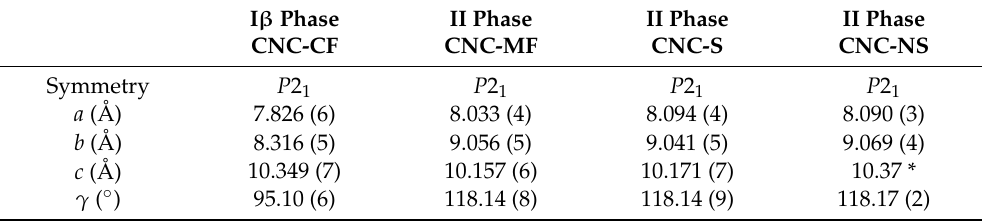
Table 3. Unit cell parameters obtained for the two crystalline phases I β and II featuring the investi- gated CNC